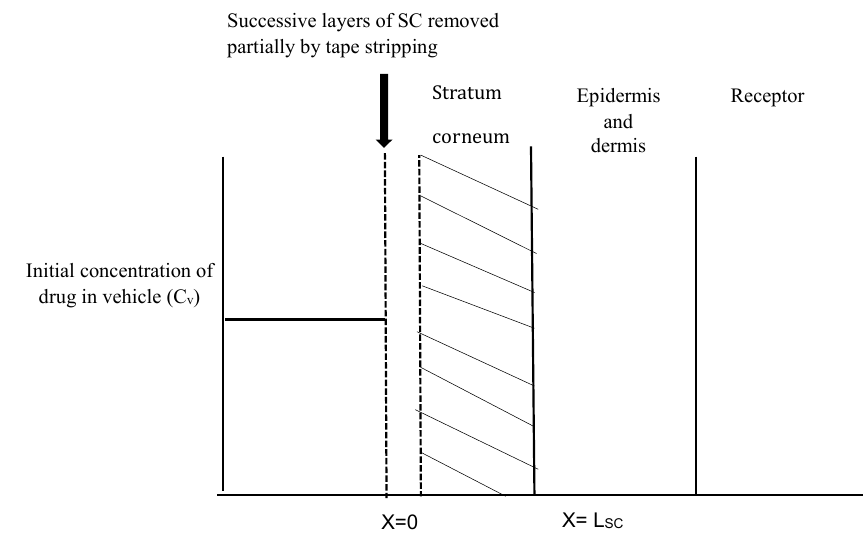
Figure 1. Schematic representation of the concentration-depth profile during the tape stripping experiment. Shaded region (i.e., stratum corneum) was stripped while drug concentration left in remaining stripped skin was recorded at end of experiment.